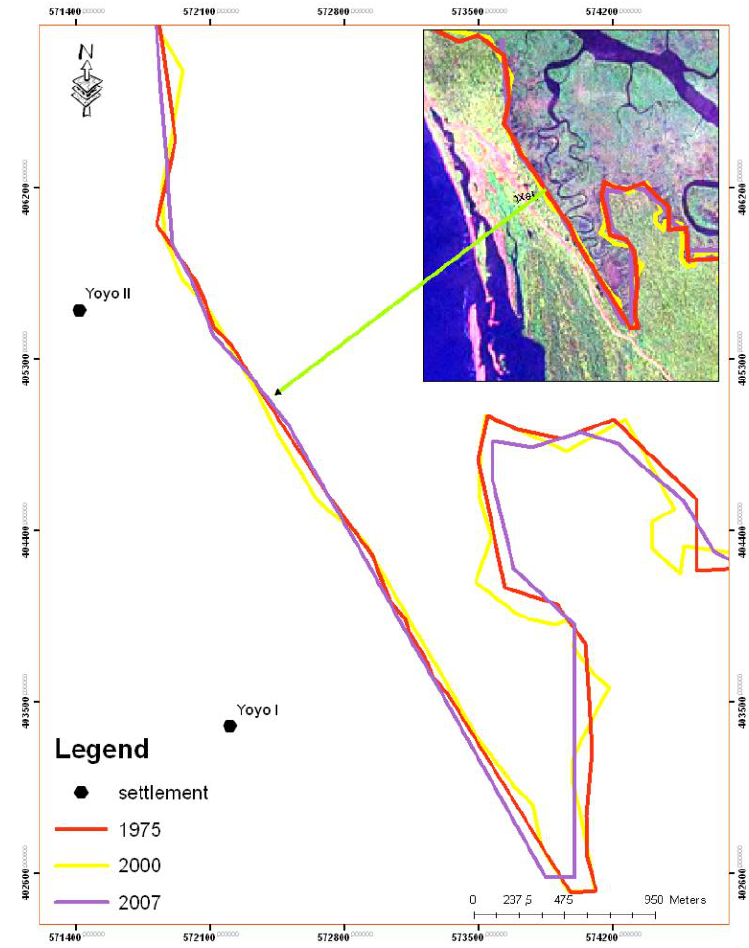
Figure 6. Mangrove landward margin change; near to Yoyo I and II villages segments, Cameroon estuary, Cameroon.